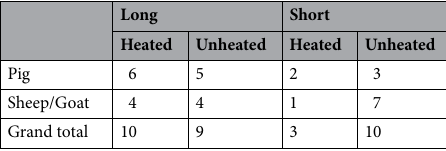
Table 4. Number of samples classified as heated or unheated according to element